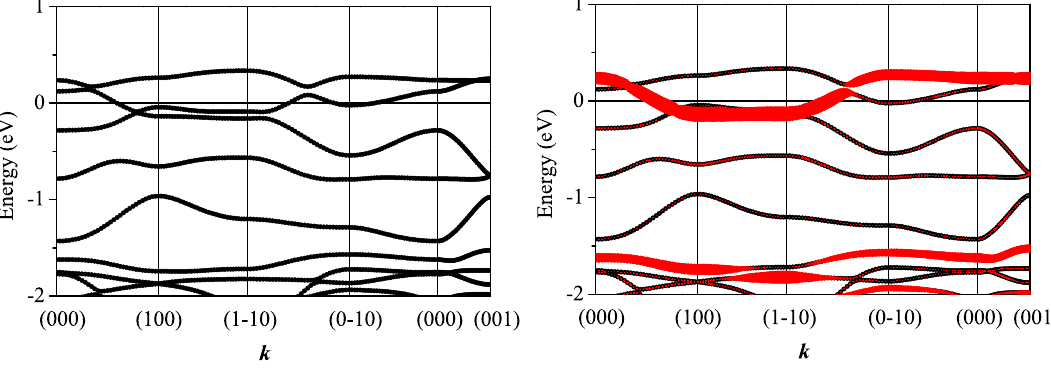
Figure 5. Electronic band dispersions (left side) and Cu 3d contribution therein (right side) for non-magnetic Cu(tmdt) . k vectors are shown in units of ( a */2, b */2, c */2). 2